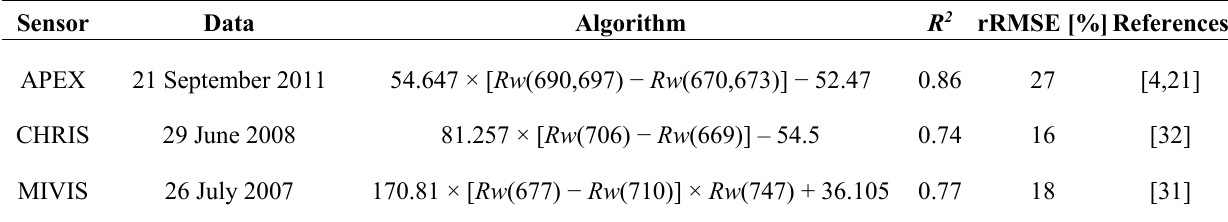
Table 1. List of algorithms with related accuracy ( R 2 ) used to transform remote-sensed reflectances ( Rw ) into chlorophyll- a (Chl- a ) concentration maps. The rRMSE (relative Root Mean Square Error) gives the percentage error when the algorithms are applied to the